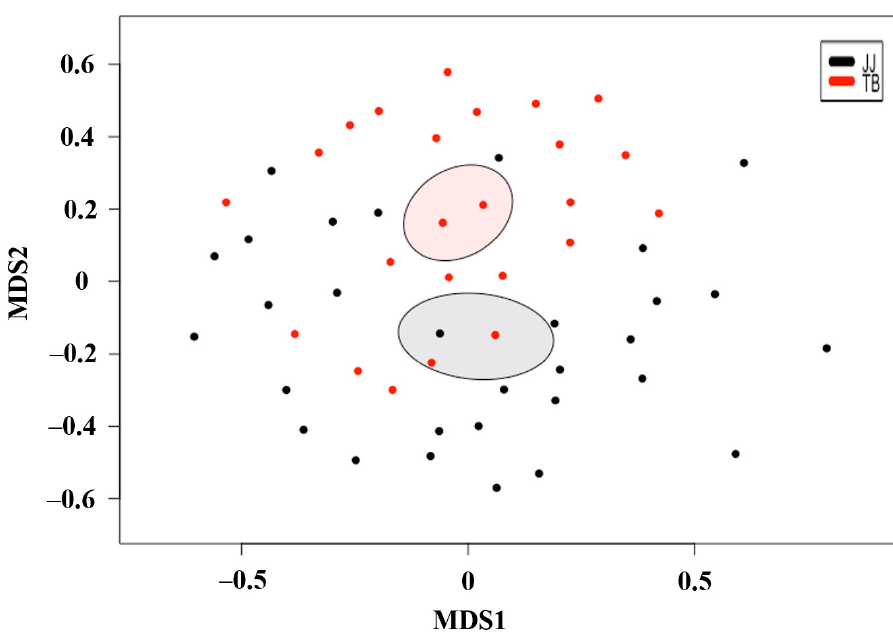
Figure 2. Microbial community comparison based on non-metric multidimensional scaling of Jeju and Thoroughbred horses. Red and black colors indicate microbiota for Jeju and Thoroughbred horses, respectively. JJ; Jeju horse, TB; Thoroughbred horse.